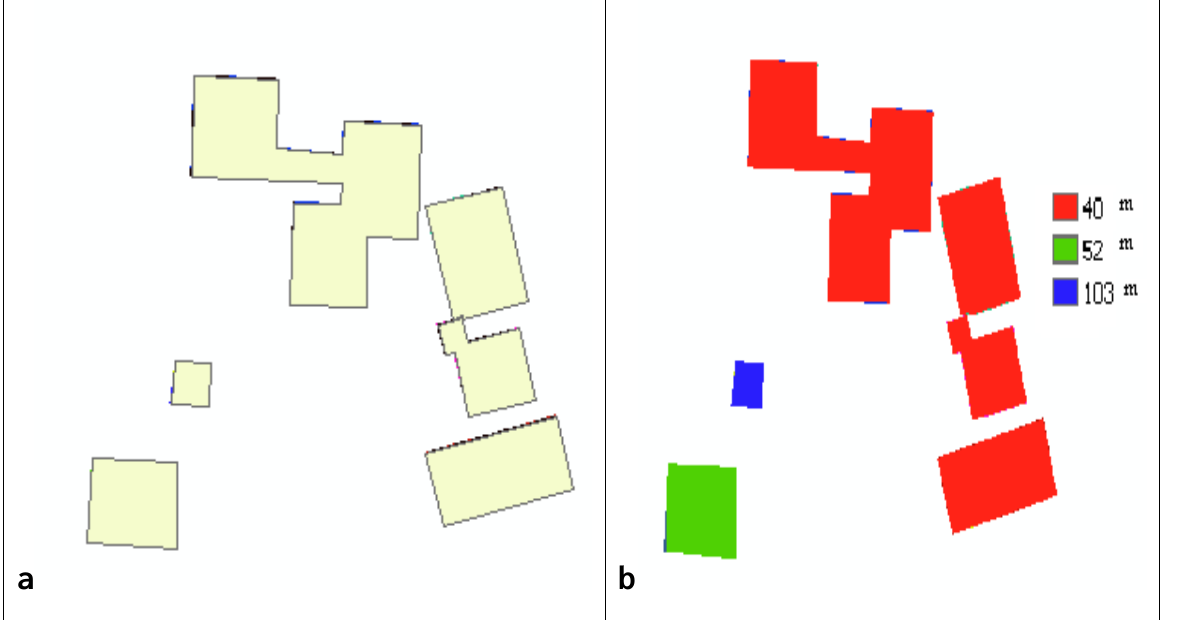
Fig. 8 a: Georefrenced grid representing the Buildings as polygons. b: Reclassified polygons, the assigned color referring to the height